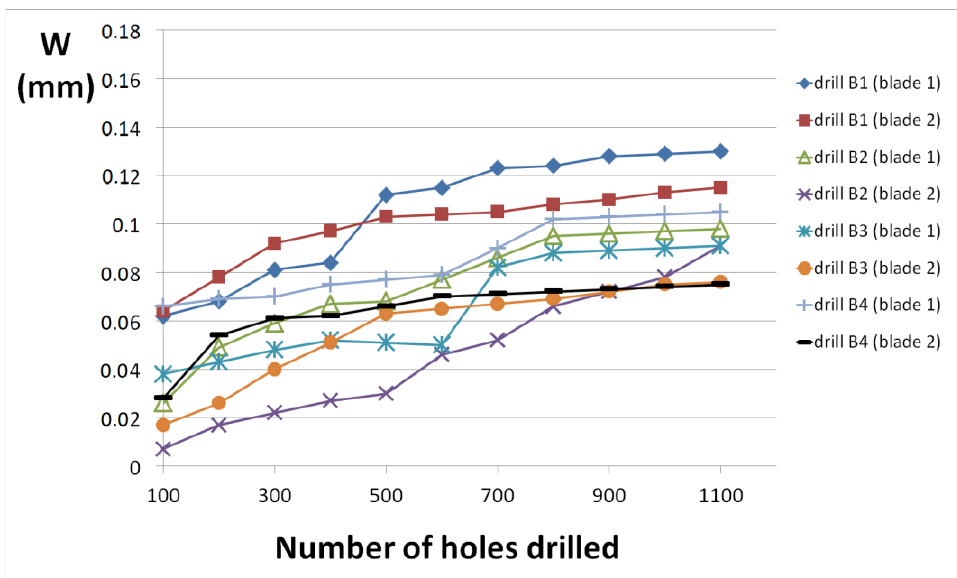
Figure 10. The blade wear curves for drill bits from Group B (experimental group containing four two-blade tools that were coated with “TiN/AlTiN”). R 2 stands for the coefficient of determination.